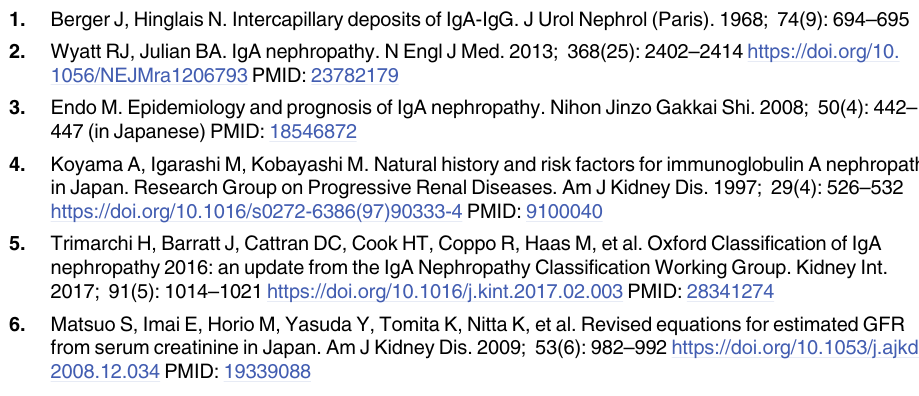
S1 Table. Clinical findings of each method to collect